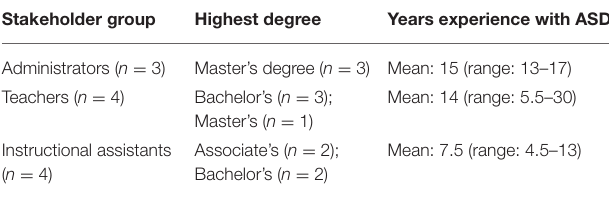
TABLE 1 | Stakeholder information. Stakeholder group